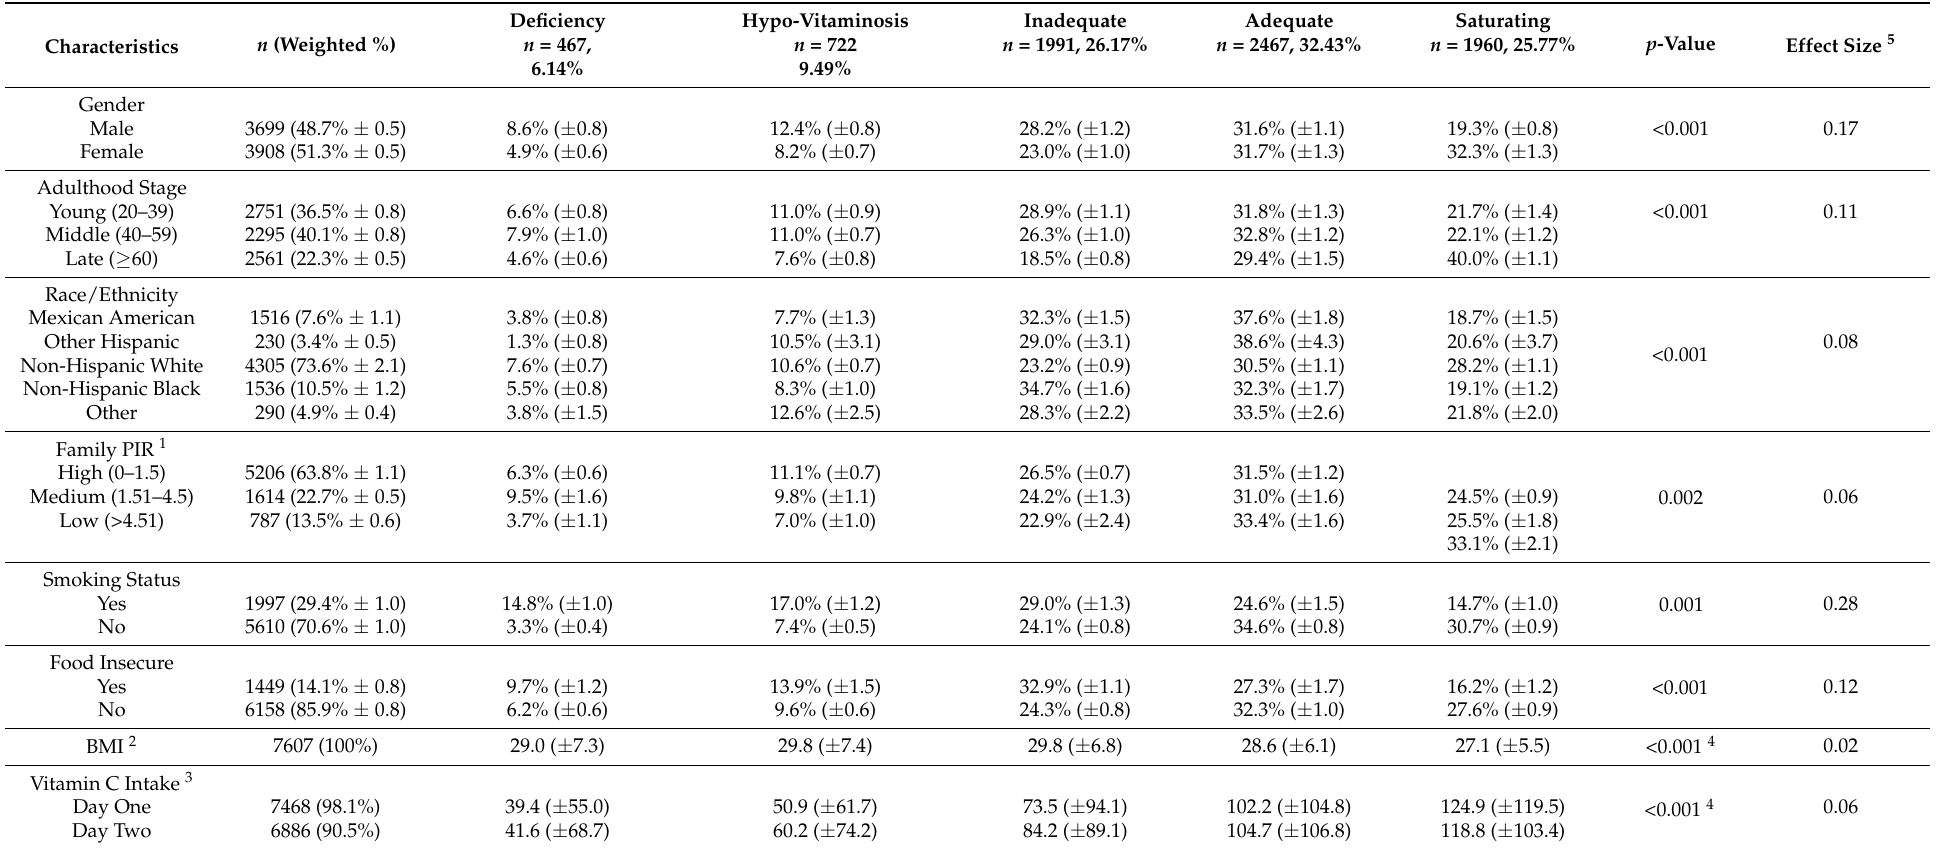
Table 2. Sample Characteristics by Plasma Vitamin C